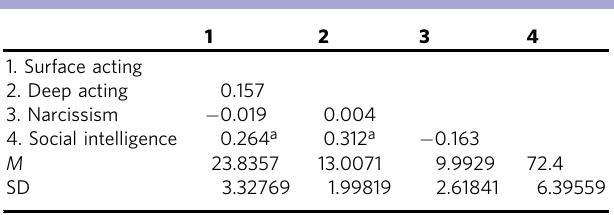
Table 3 Correlations and descriptive statistics for hypothesis testing ( N = 140).